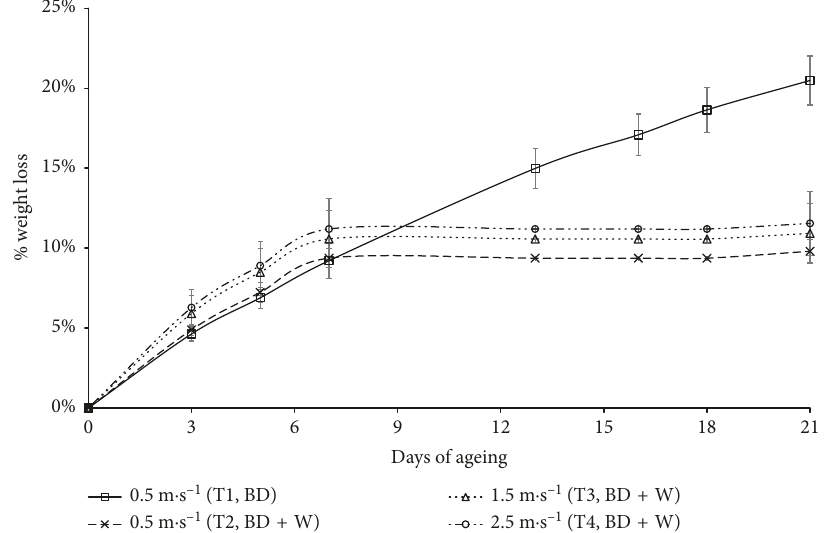
Figure 2: Average % weight loss of lean beef striploins of four different ageing treatments across different ageing times (days). BD: in-bag dry-ageing; W: wet-ageing. T1: BD at 0.5m s ·